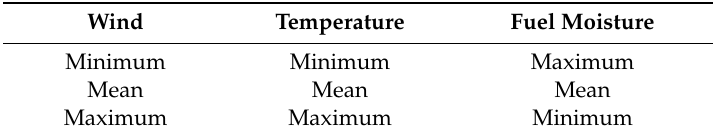
Table 2. Representative weather scenarios modeled in Fire and Fuels Extension (FFE) combined statistics calculated from remote automated weather stations (RAWS) weather observations covering the time period during which each plot is believed to have